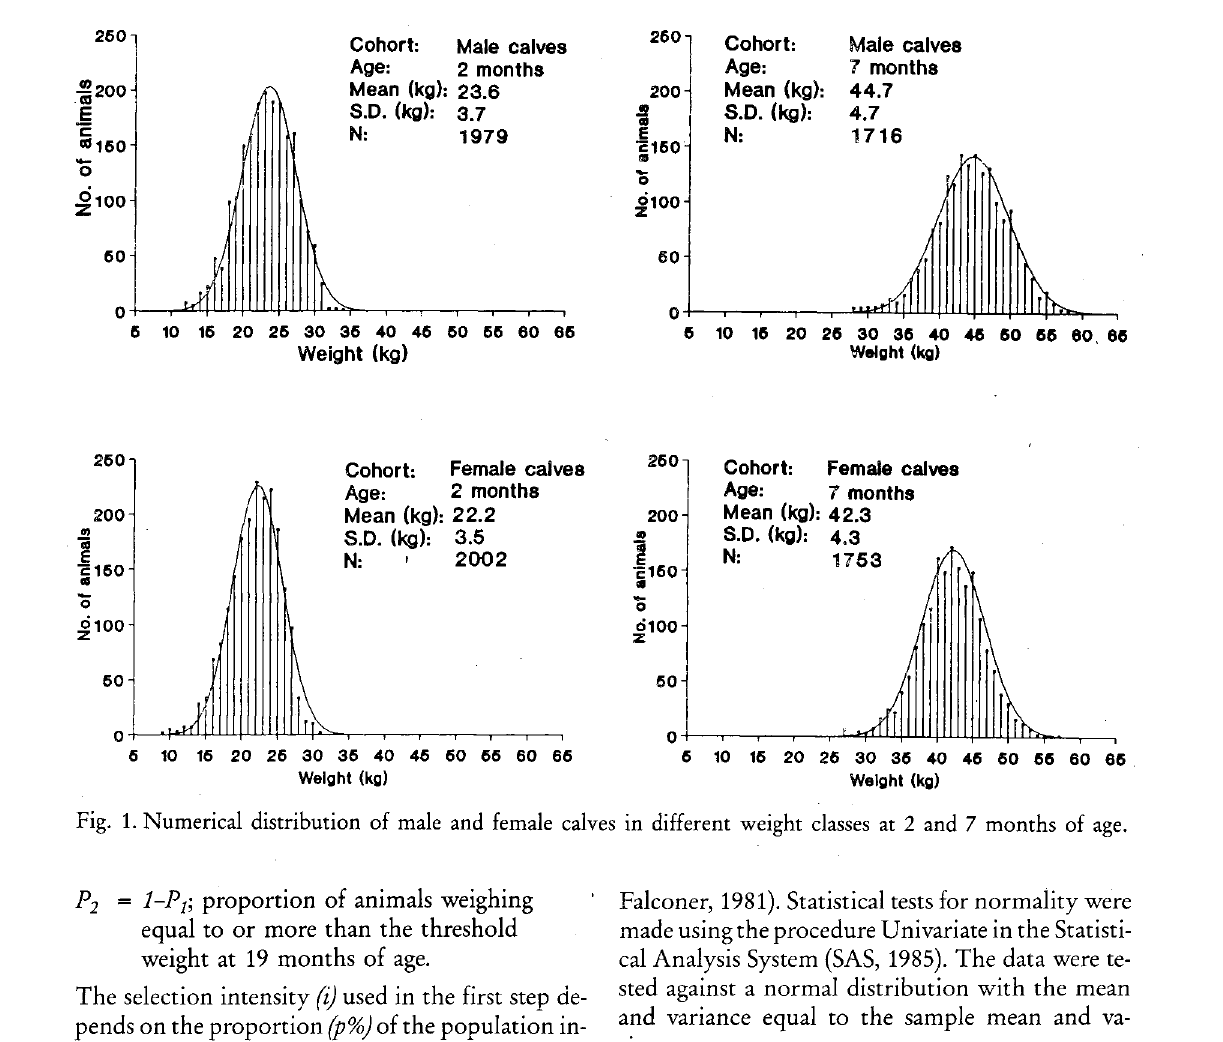
Fig. 1. Numerical distribution of male and female calves in different weight classes at 2 and 7 months of age. P = 1-Pf, proportion of animals weighing 2 equal to or more than the threshold weight at 19 months of age.